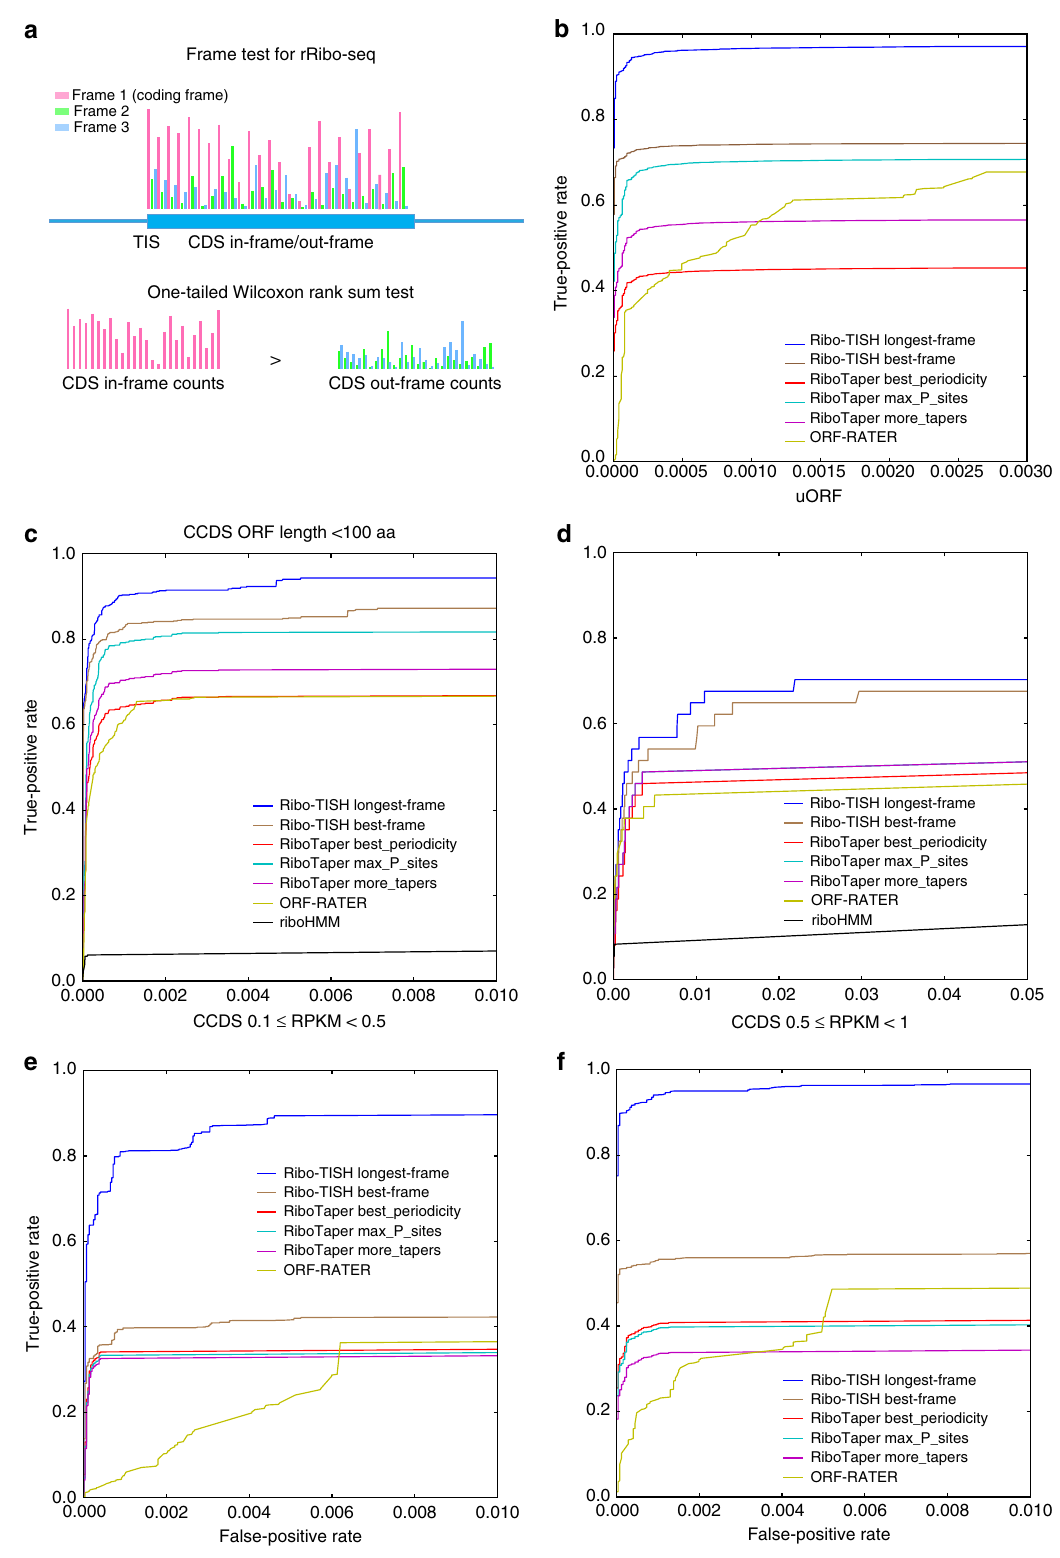
Fig. 5 Evaluating the performance of different methods in ORF prediction. a An illustration of how the frame test was performed to predict ORFs from rRibo-seq data by Ribo-TISH. b ROC curves across six strategies of ORF predictions implemented in Ribo-TISH, RiboTaper, and ORF-RATER. An RPKM value of 1 was used as a cutoff to de fi ne actively translating genes for positive and negative sets. c The short ORFs ( < 100 aa) of CCDS in Ensembl or d the experimentally validated uORFs curated by uORFdb were used as a positive set (RPKM ≥ 1) for the ROC analyses across 7 strategies implemented in Ribo- TISH, RiboTaper, ORF-RATER, and riboHMM. ROC curves across six strategies implemented in Ribo-TISH, RiboTaper, and ORF-RATER when the annotated ORFs of CCDS in Ensembl, with RPKM e between 0.1 and 0.5 or f between 0.5 and 1, are used as a positive set,